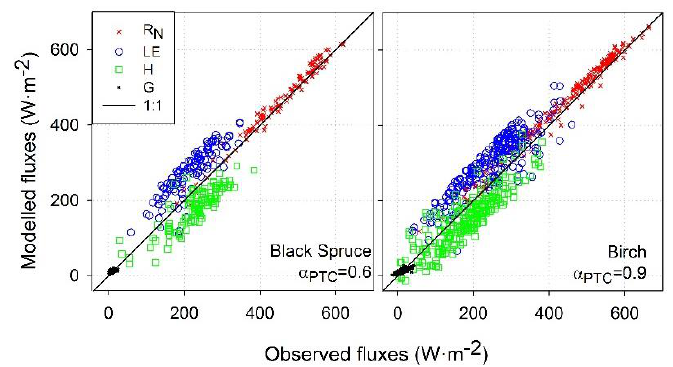
Figure 8. Modelled vs. observed surface fluxes comparison at satellite pass using α PTC of 0.6 and 0.9 for black spruce and birch settings, respectively, G estimated by the G-T RAD approach and T RAD from MODIS data. Perfect agreement is represented by the 1:1 line.